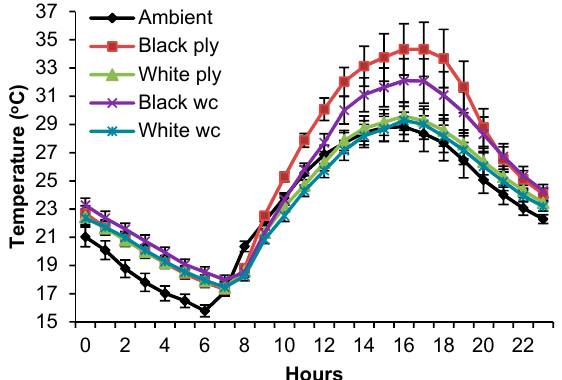
Figure 2. Warmest chamber temperature in each box design and ambient temperature over 24-h. Hourly means ( ± SE) are for the 5-day summer period. ply = plywood; wc = wood-cement.